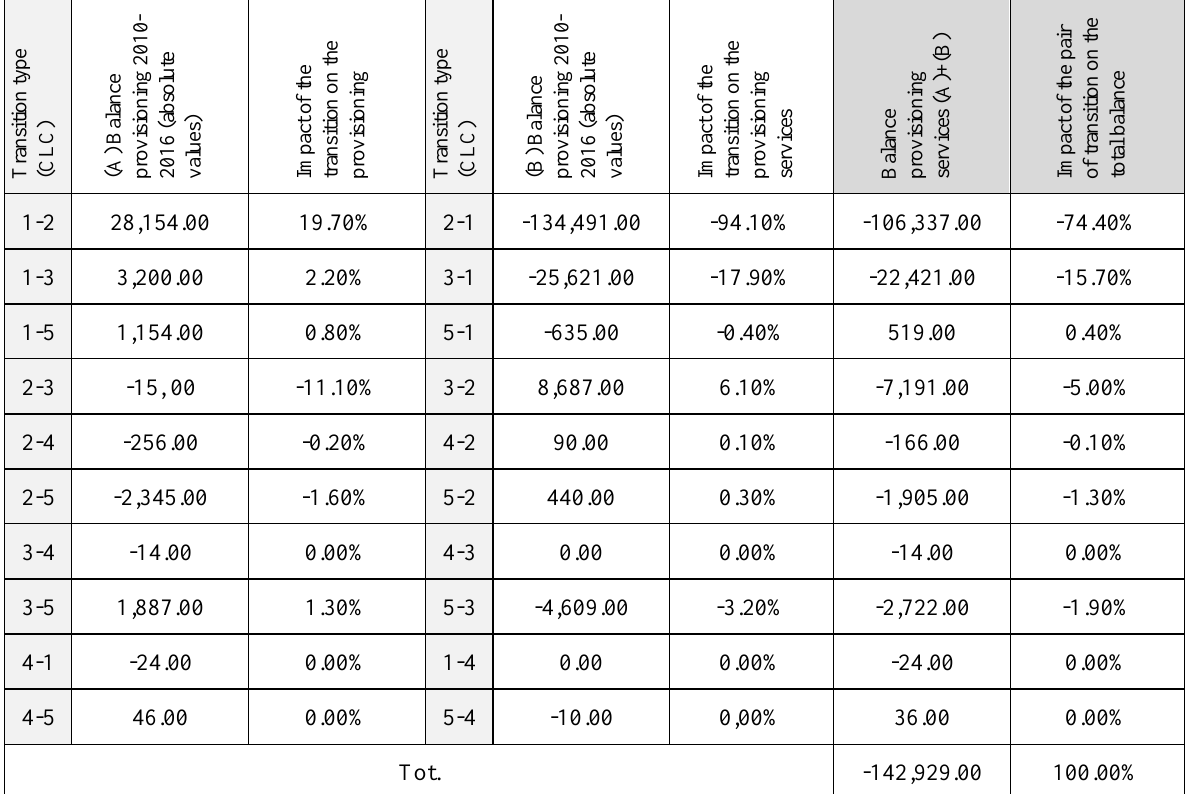
Table 7. Transition 2010-2016 of provisioning: contributions of transitions between different LULC classes at the first classification level.